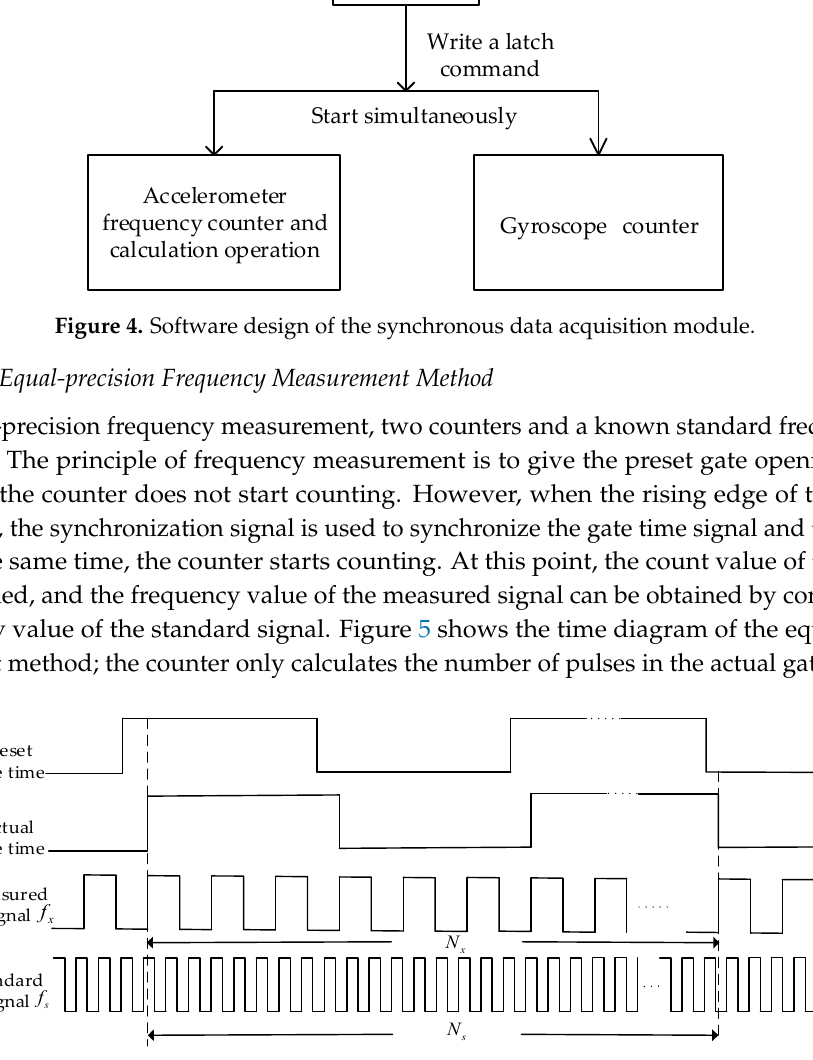
Figure 5. The time diagram of the equal-precision frequency measurement method.